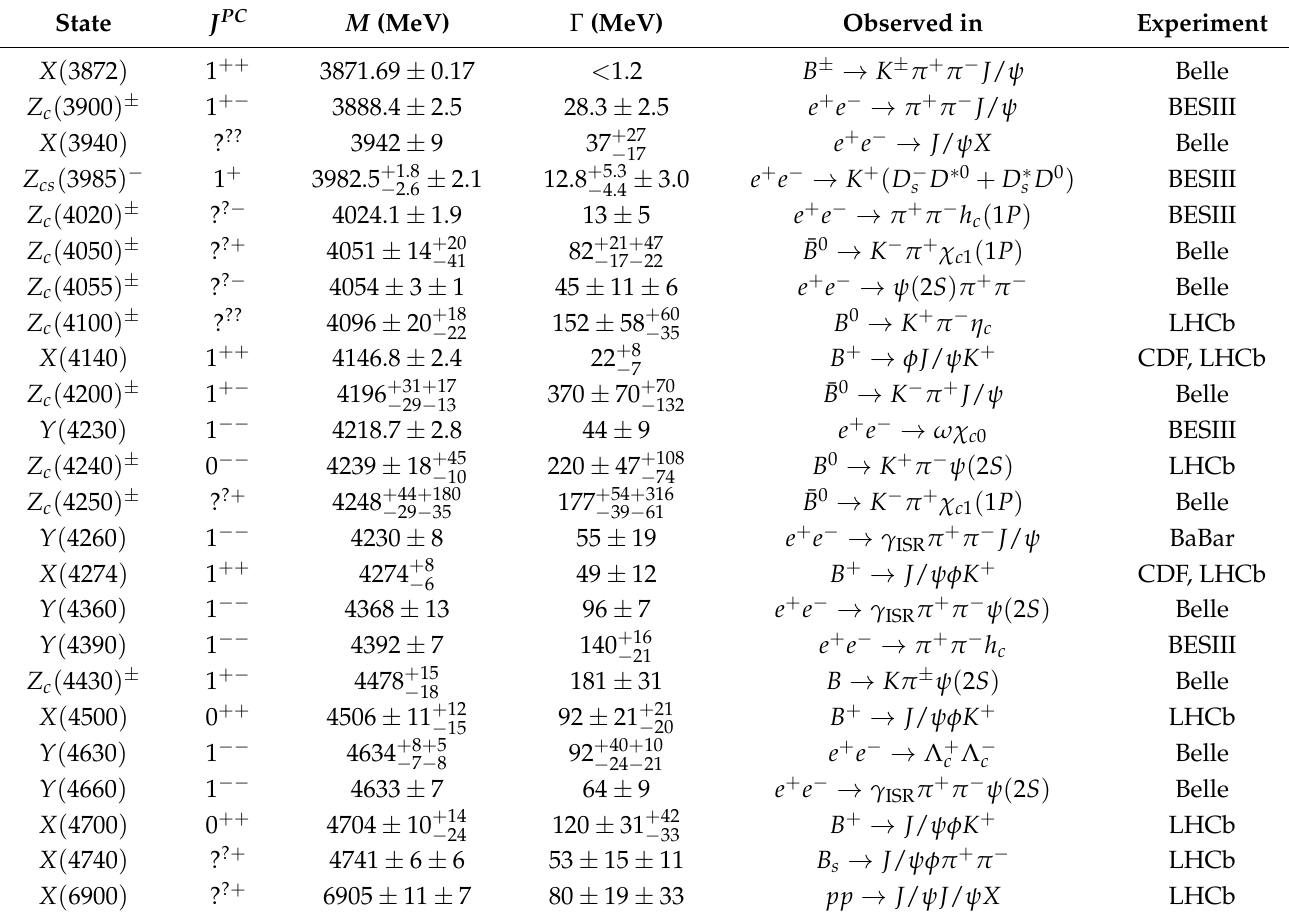
Table 1. Experimental data on hidden-charm exotic